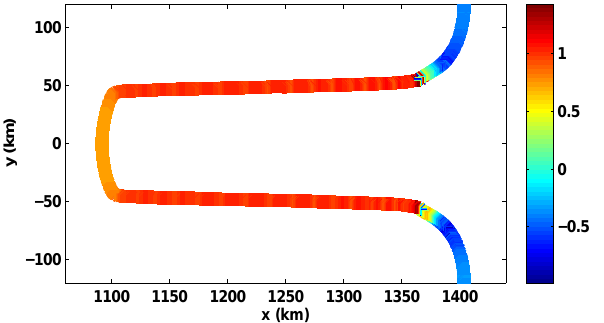
Fig. 3. The tangential buttressing number K T (defined by Eq. 11). All model parameters are the same as for Fig.